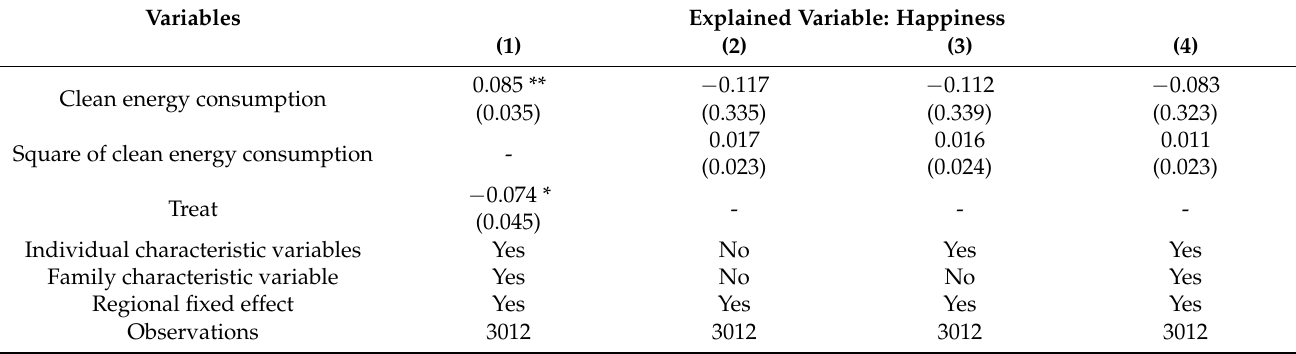
Table 11. Moderator and further